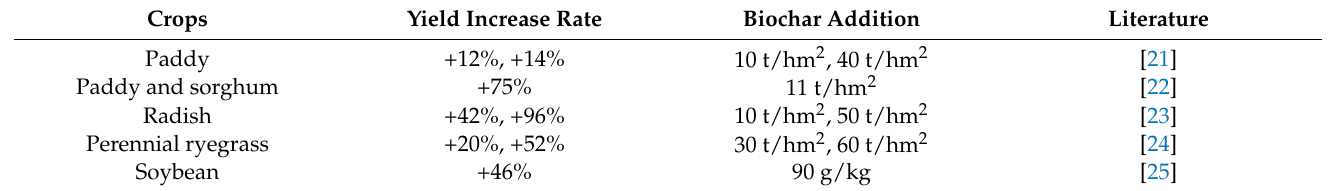
Table 1. Study on the effect of biochar on crop